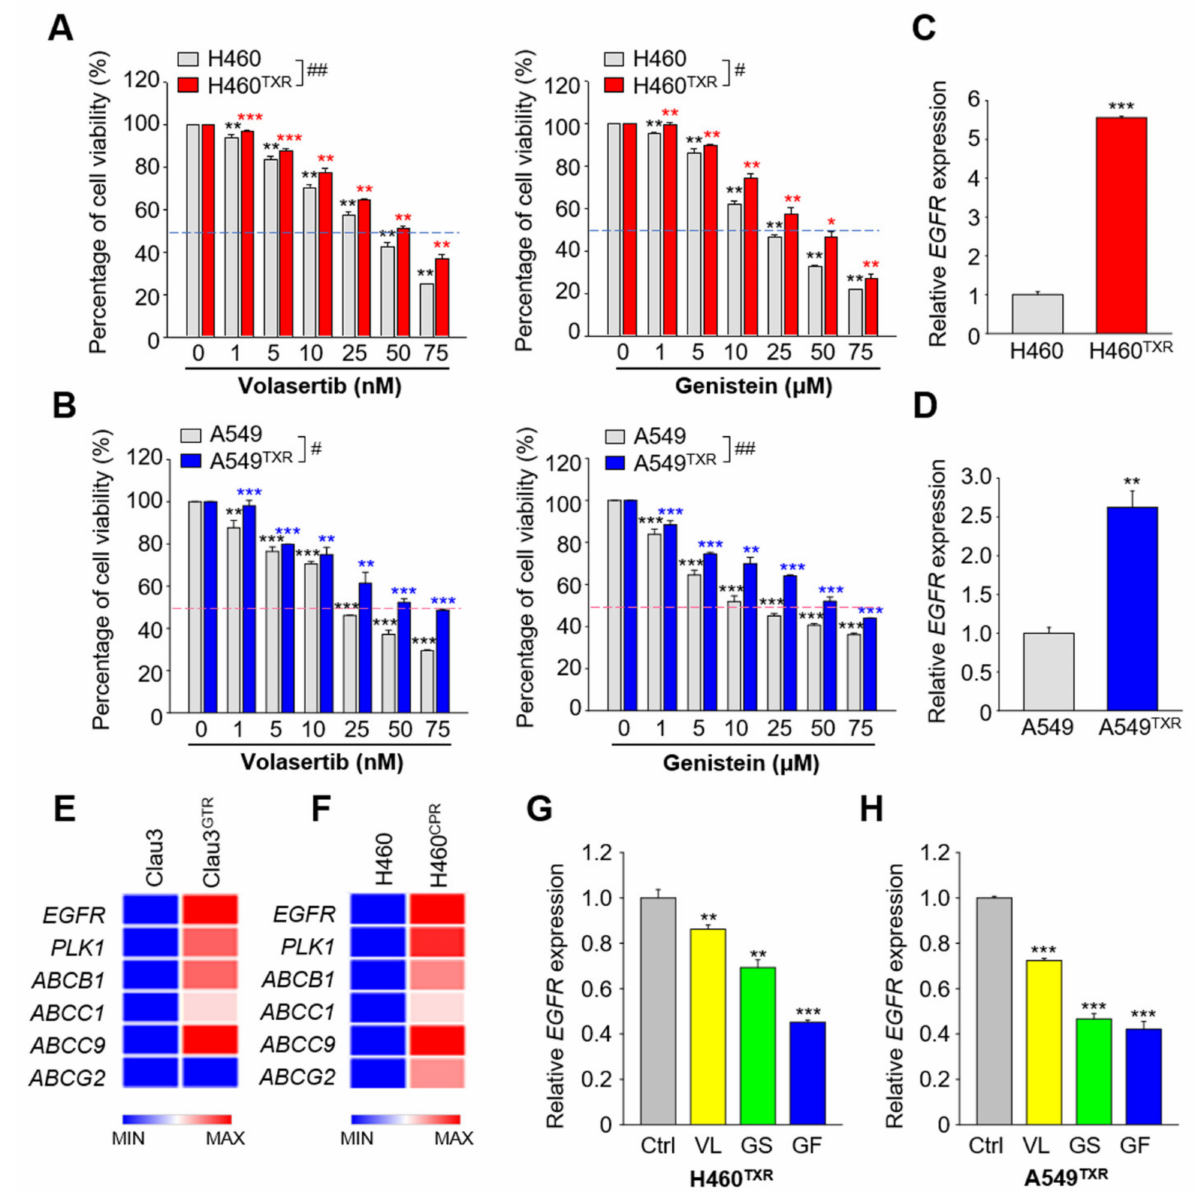
Figure 3. Paclitaxel-resistant LUAD was sensitive to treatment with EGFR-specific inhibitor gefitinib. ( A , B ) NCI-H460 (H460) and NCI-H460 TXR (H460 TXR ) and (B) A549 and A549 TXR cells were grown for 48 h in the presence of 1, 5, 10, 25, 50, or 75 nM volasertib or 1, 5, 10, 25, 50, or 75 µ M genistein for 48 h. The percentages of viable cells were measured by cell viability assay. The means ± SEMs (error bars) of data from at least three experiments are shown *, p < 0.05; **, p < 0.01; ***, p < 0.001 compared with control of each cells. #, p < 0.05; ##, p < 0.01 compared with mock of parental H460 or A549 cells. ( C , D ) Quantitative RT-PCR was performed to evaluate the mRNA level of EGFR in ( C ) H460 and H460 TXR and ( D ) A549 and A549 TXR cells. Three independent experiments were performed. The relative expression of mRNA was plotted. ***, p < 0.001. ( E ) A heatmap was generated from Morpheus, showing the expression levels of EGFR, PLK1, ABCB1, ABCC1, ABCC9 , and ABCG2 in gemcitabine-resistant Clau3 (Clau3 GTR ) cells from gene set GSE6914. ( F ) A heatmap was generated from Morpheus, showing the expression levels of EGFR, PLK1, ABCB1, ABCC1, ABCC9 , and ABCG2 in carboplatin-resistant